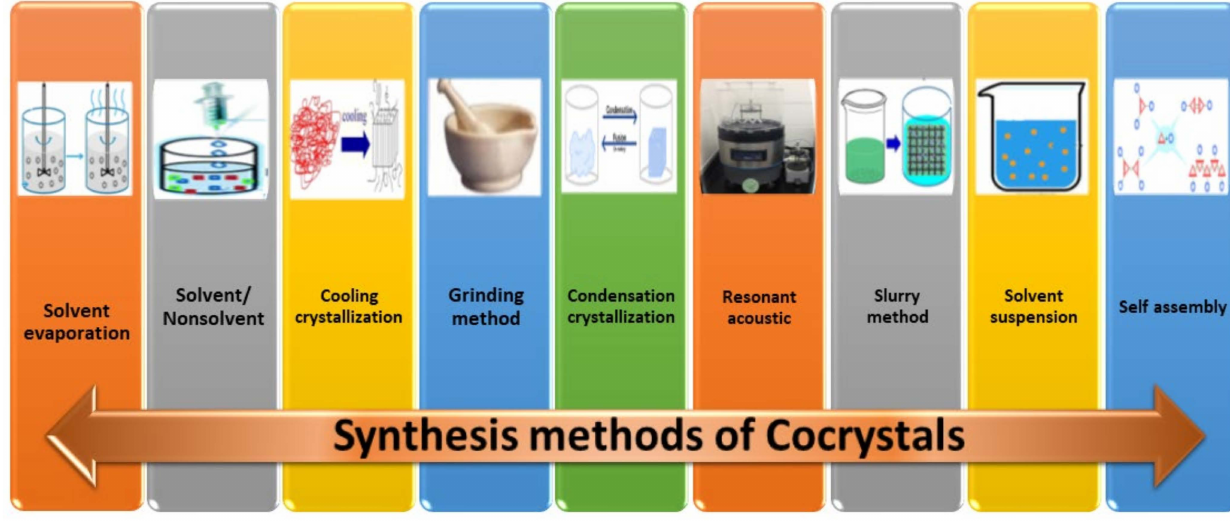
Figure 2. Synthesis methods of energetic